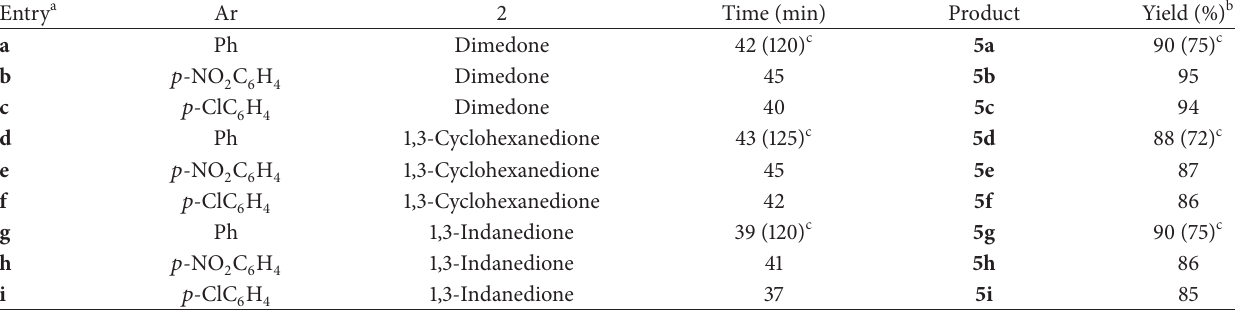
Table 1: Synthesis of heteroaryl substituted 1,4-dihydropyridines in the presence of cellulose-sulfuric acid